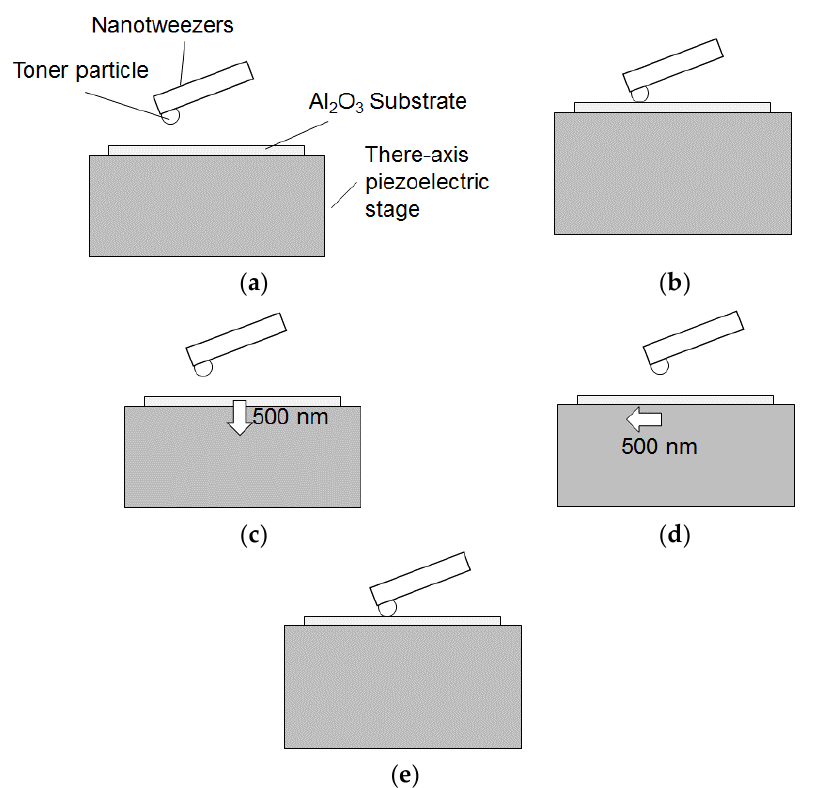
Figure 5. Procedure for a contact test between a toner particle and an aluminum oxide substrate: ( a ) before approach; ( b ) approach/contact particle; ( c ) withdraw from particle; ( d ) horizontal translation; ( e ) approach/contact particle.